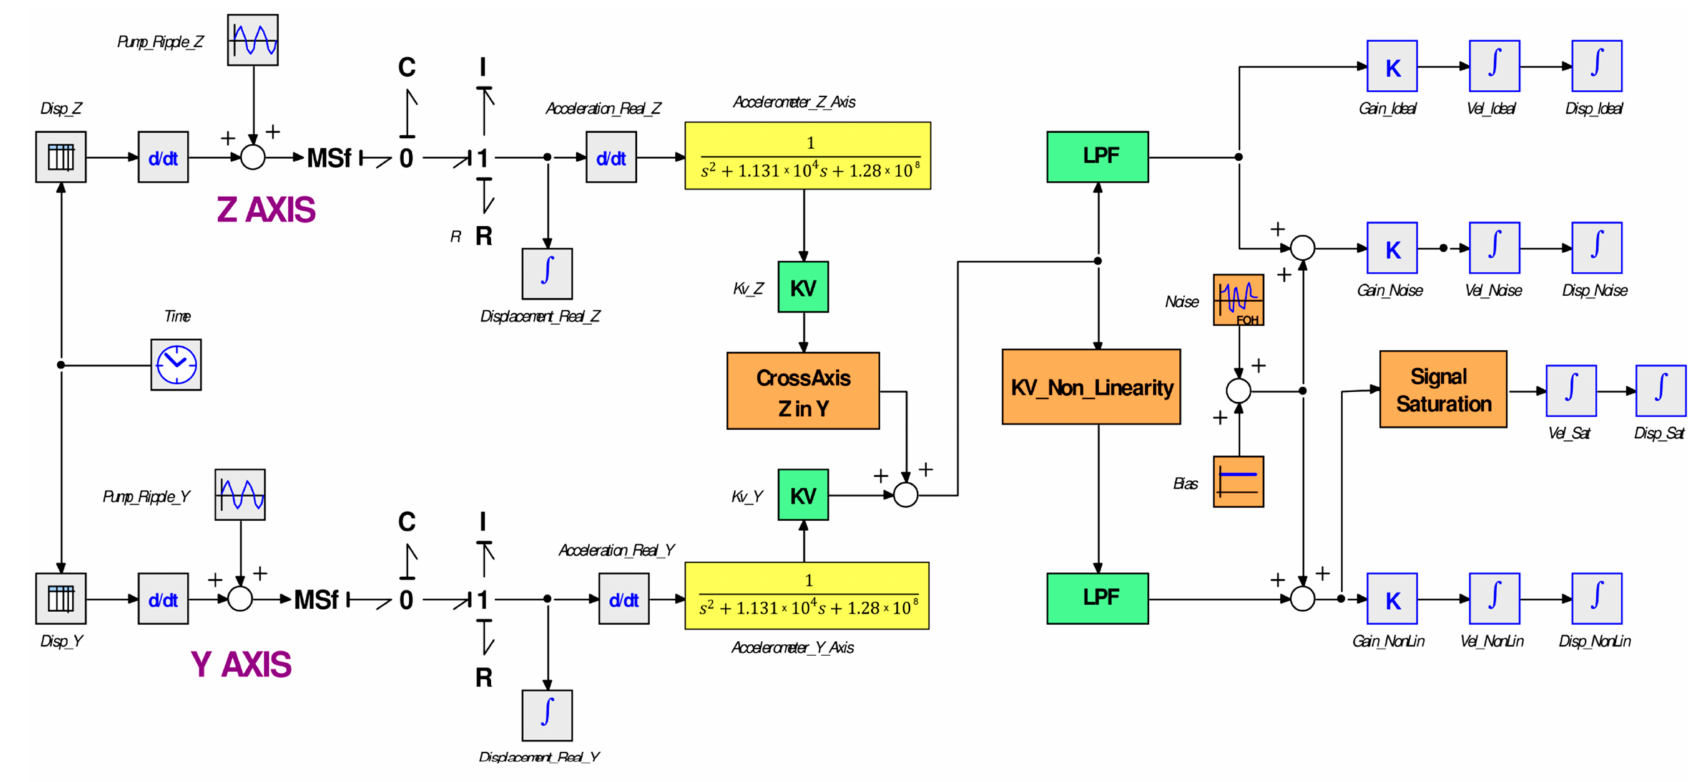
Figure 4. Bond graph model for Y axis